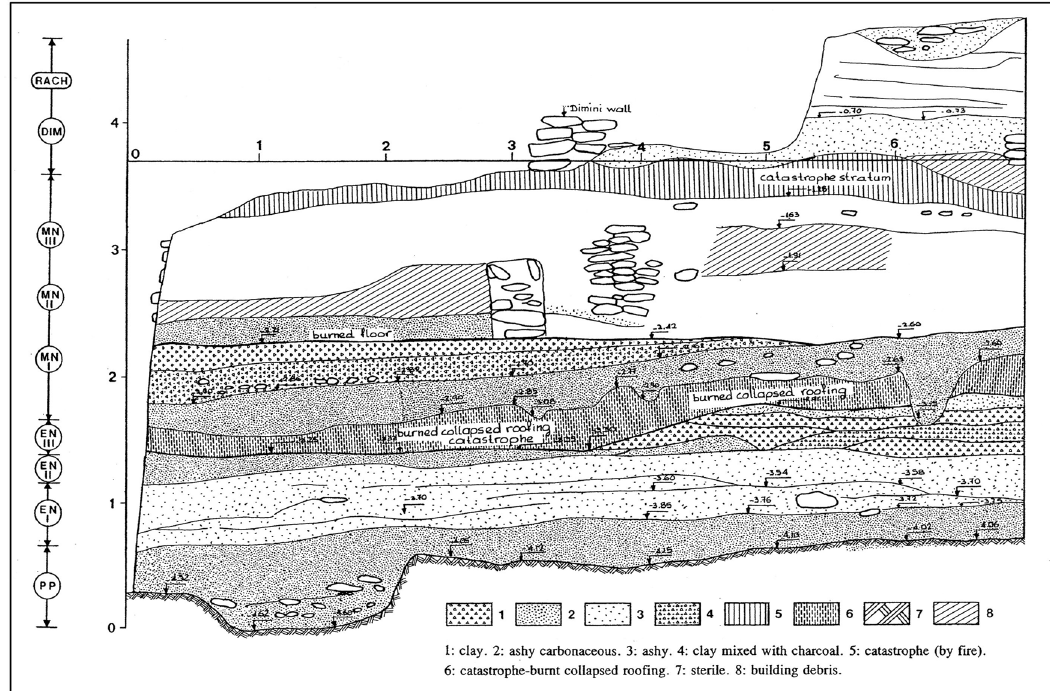
Figure 3: Sesklo tell: stratigraphic pro fi le showing the sequence from the Early Neolithic to the end of the Middle Neolithic, a period of abandonment and reoccupation in the Late Neolithic II ( Wijnen, 1981, Figure 5 )